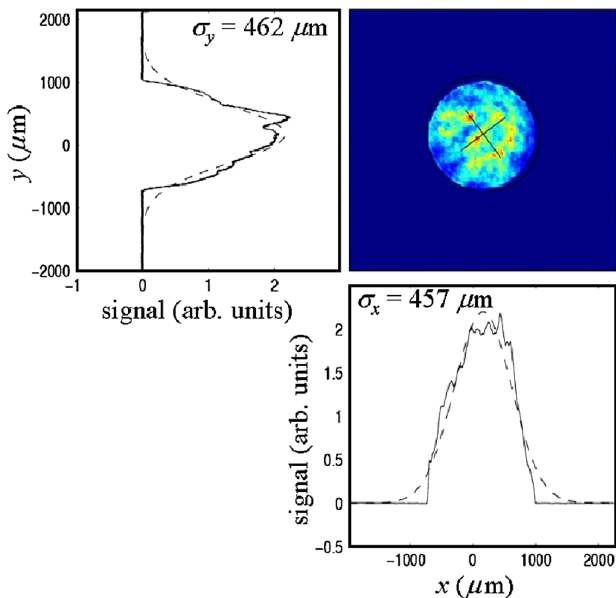
FIG. 4. (Color) The drive laser spot on the virtual cathode with horizontal ( x ) and vertical ( y ) projections over the full image. Gaussian (dashed) curves with the same rms are simply overlaid for comparison.